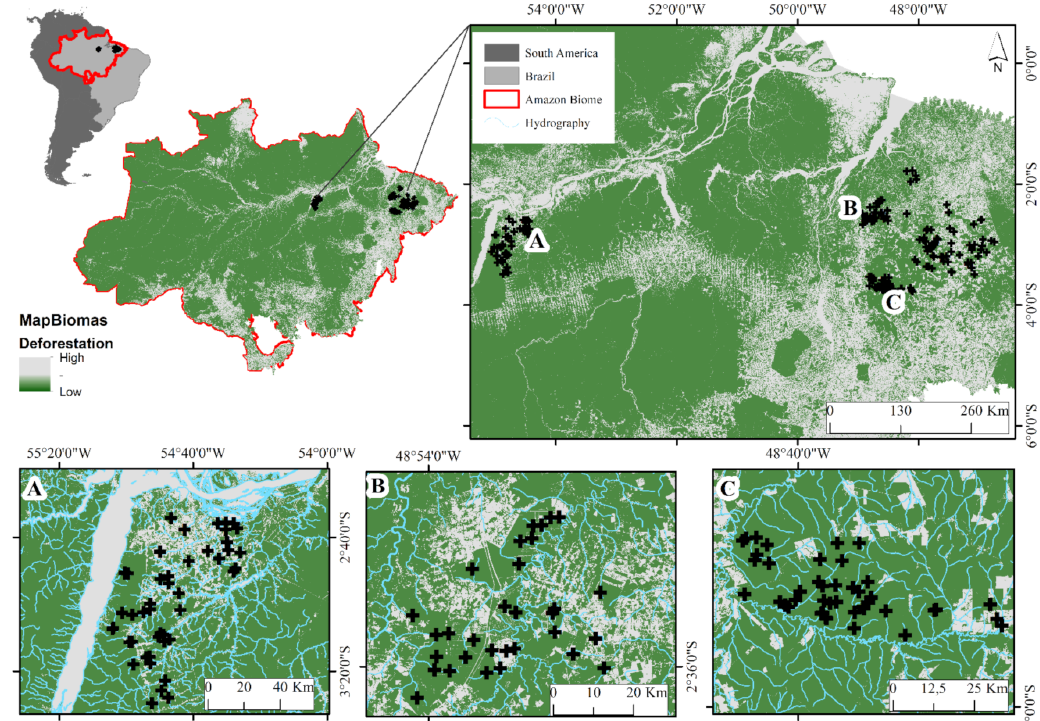
Figure 1. Study area (streams). Tapajos Basin ( A ), Capim basin ( B ) and Acar á basin ( C ), in the Bel é m. Par á , Brazil. (Source: https://mapbiomas.org/; accessed on 20 May